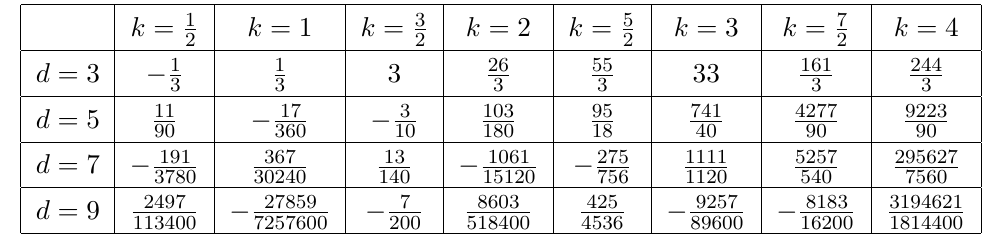
theory induced by the Ψ (1 , 0)